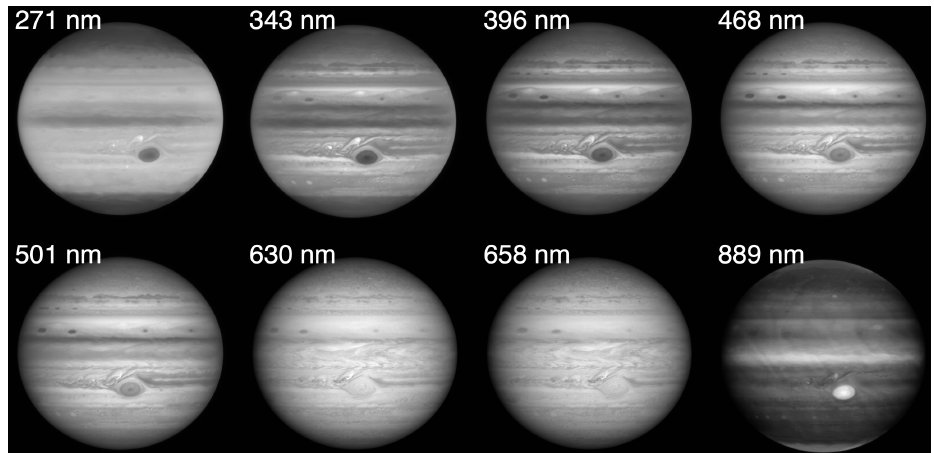
Figure 4. Jupiter’s appearance at UV and visible wavelengths. September 2021 Hubble data show variation in Jupiter’s latitude bands with wavelength. Jupiter is dark in the 889 nm methane gas absorption band, with the highest features (the GRS and the polar haze caps) appearing brightest; artificial fringing is apparent in that image, and in all long wavelength narrow-band WFC3